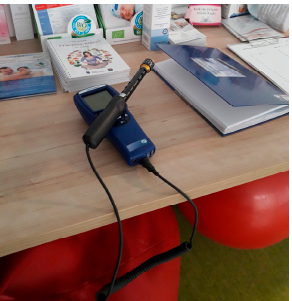
Figure 1. The location of the instrument TSI 9565 (own